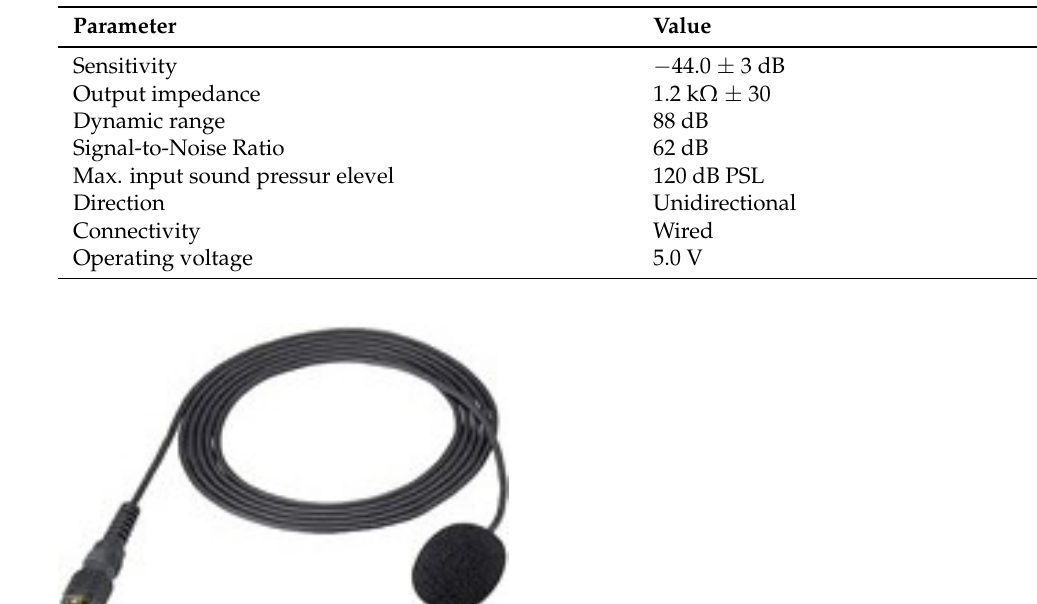
Table 1. Important parameters of Sony ECM-X7BMP microphone.